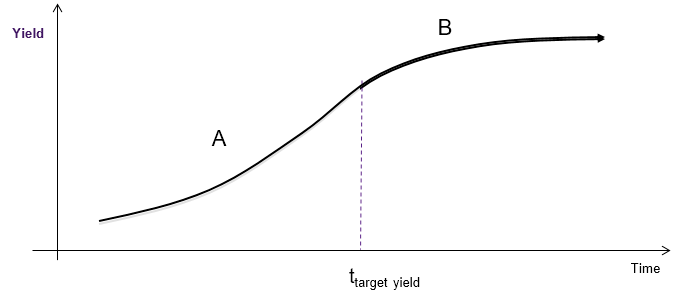
Figure 4. Graph of new product ramp and production phase.